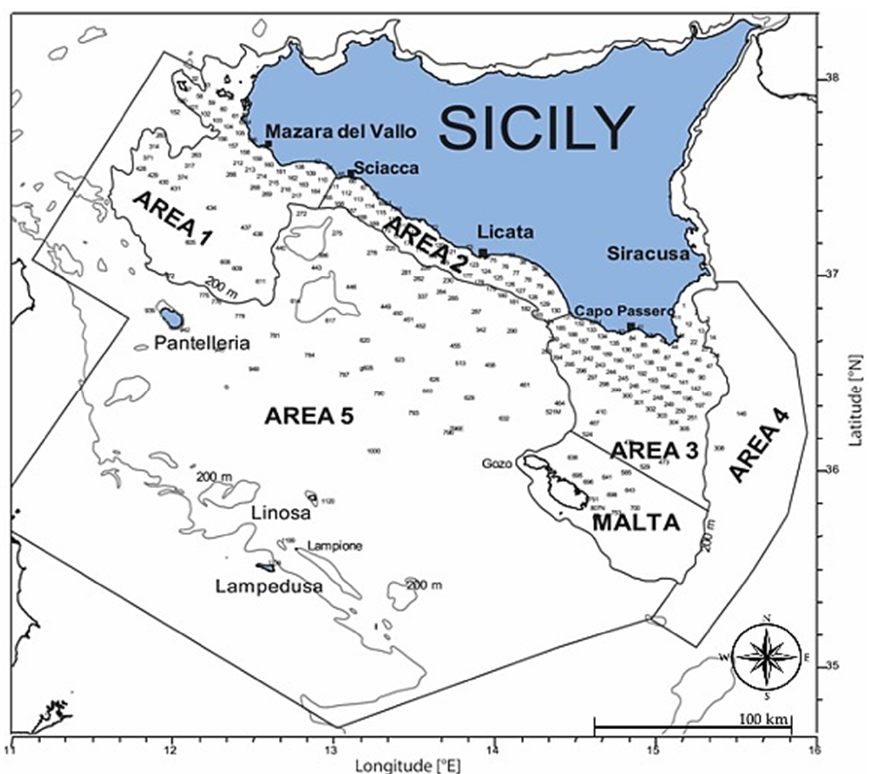
Figure 1. Sampling map. Map of the Sicilian Channel, showing the sampling stations and the six sampling areas (1, 2, 3 and Malta are within the 200 m isobaths, 4 and 5 at bottom depths >200 m).